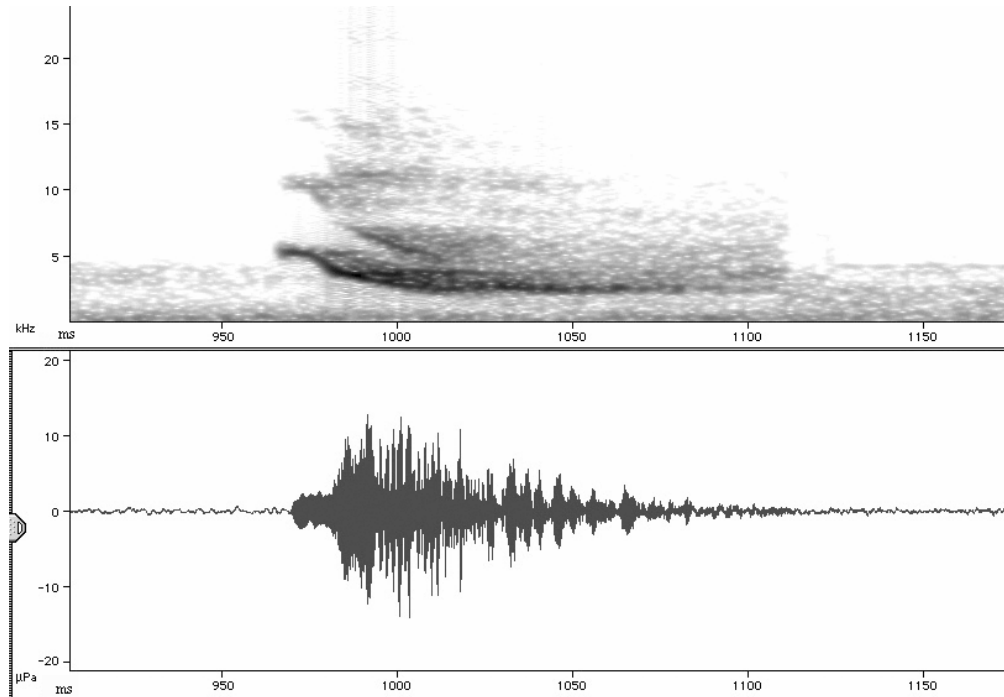
Fig. 2 – Spectrogram of father monosyllabic theme β